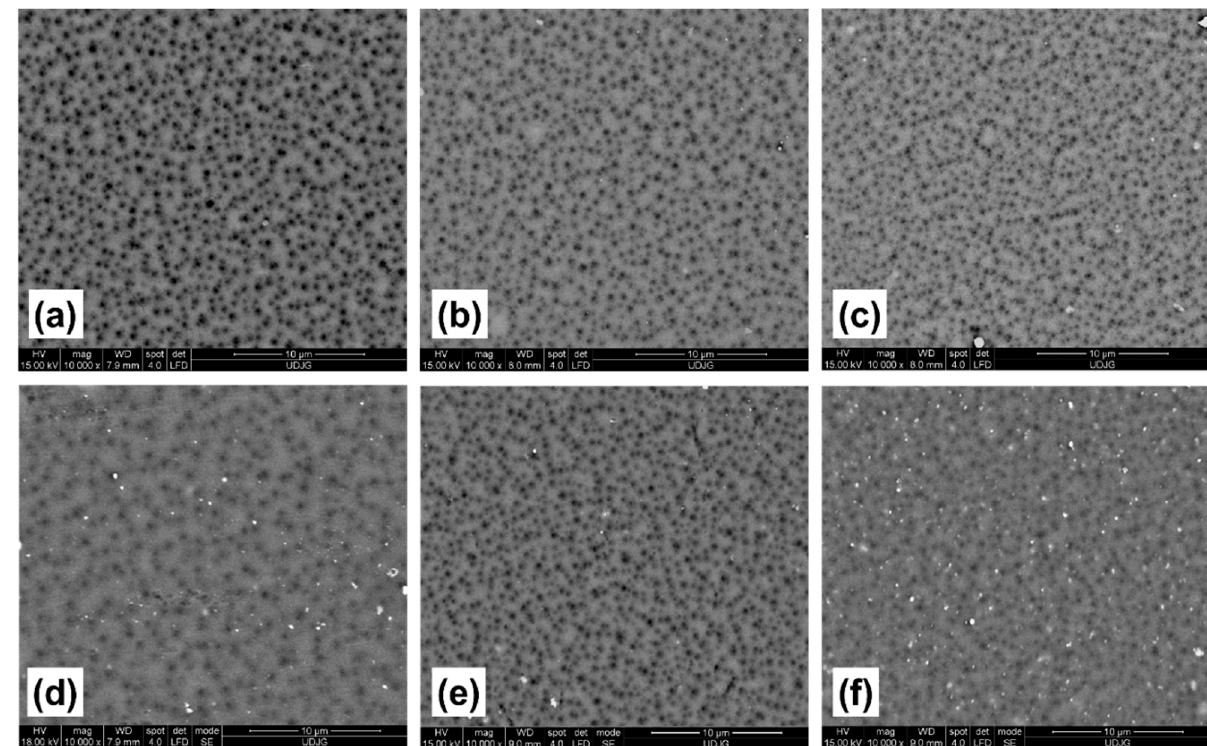
Figure 2. Surface SEM images of nanocomposite membranes modified by the addition of titanium dioxide nanoparticles. Each membrane contains a different concentration, rutile: 0.1wt.% ( a ), 0.5wt.% ( b ) and 1wt.% ( c ); and anatase: 0.1wt.% ( d ), 0.5wt.% ( e ) and 1wt.% ( f ).